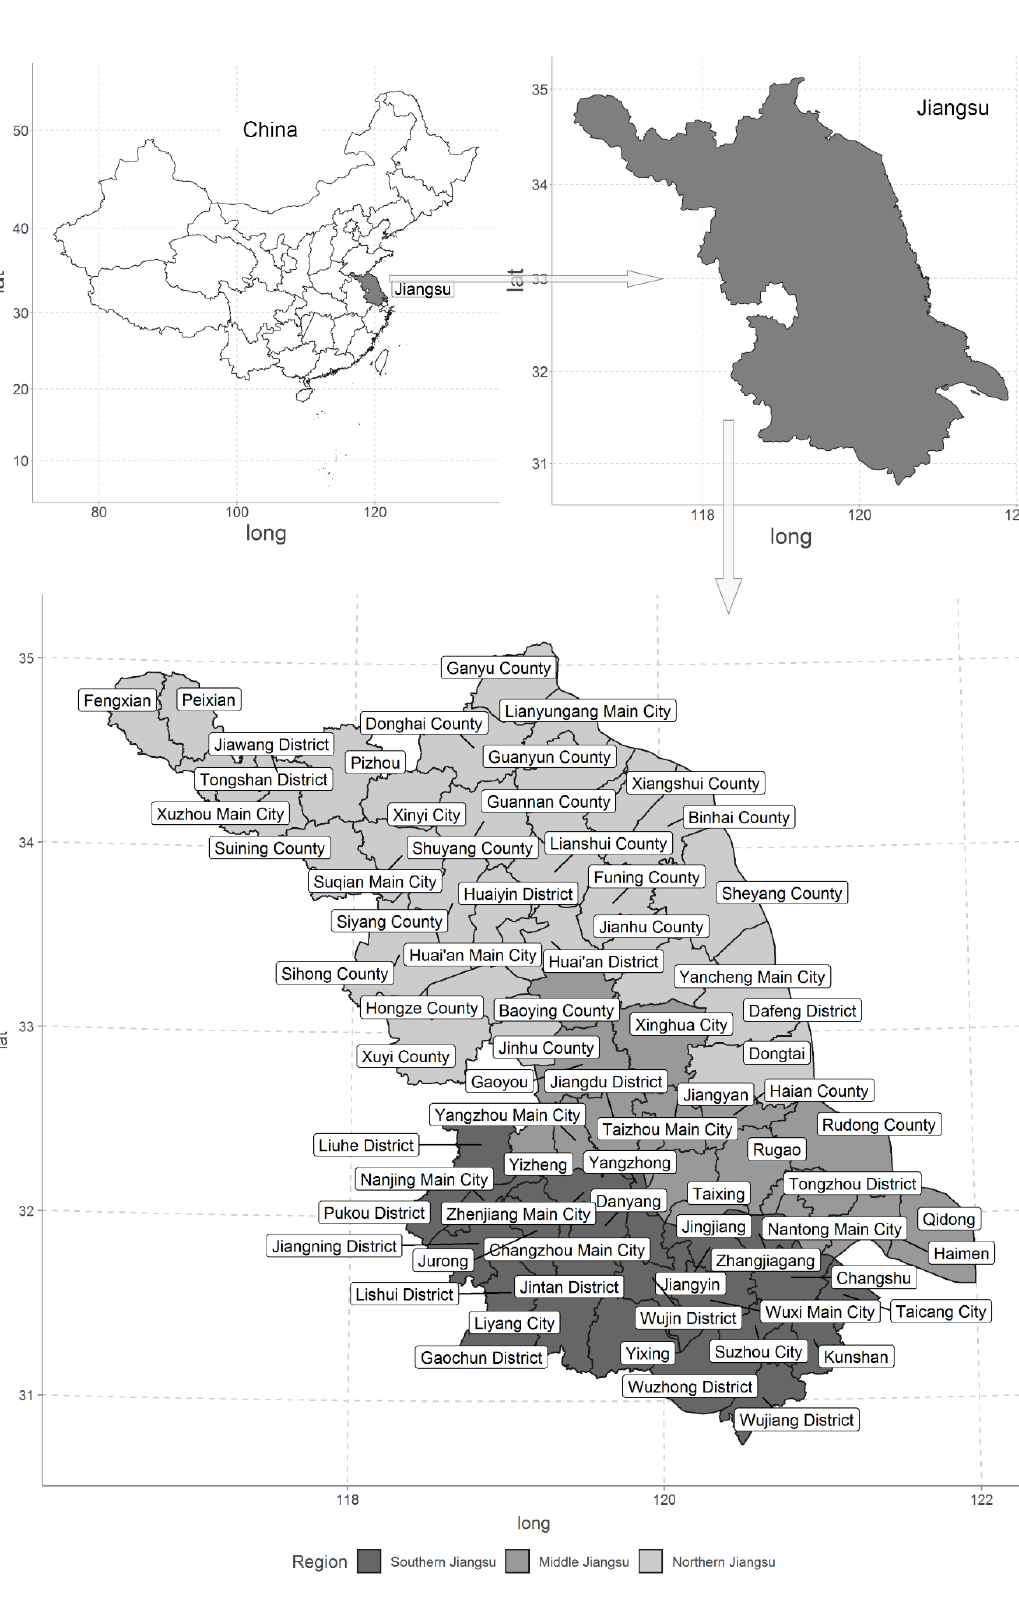
Figure 2. Administrative divisions of Jiangsu Province.